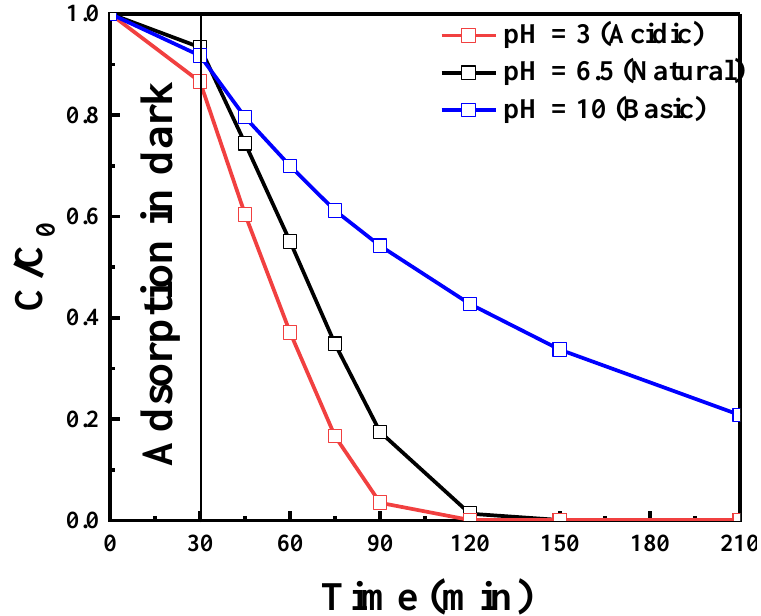
Figure 9. Photodegradation curves of phenol as a function of pH; C0 = 20 ppm, airflow = 50 mL/min, catalyst = 0.5 g/L, light source = LEDs, Catalyst = exfoliated g-C 3 N 4 .